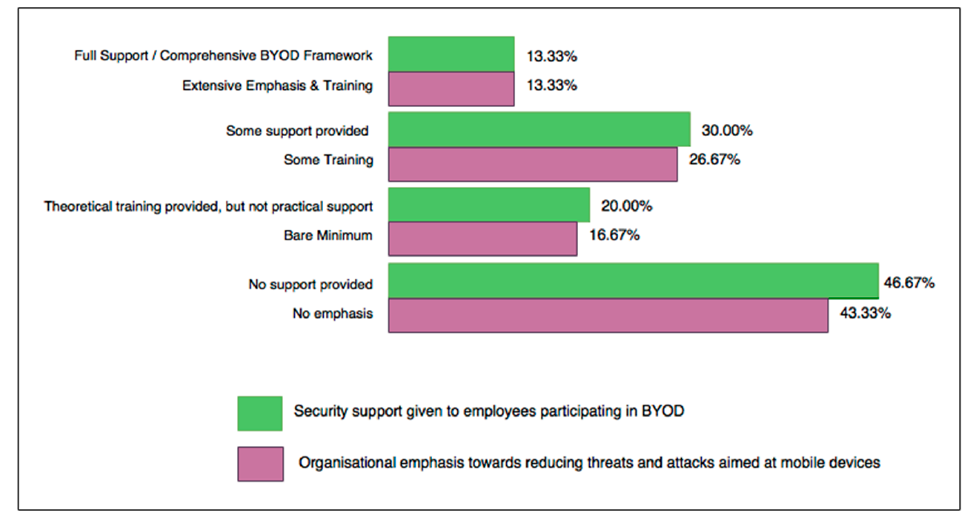
Figure 2. Organisational support for BYOD security compared to emphasis towards reducing attacks and threats in IT networks.